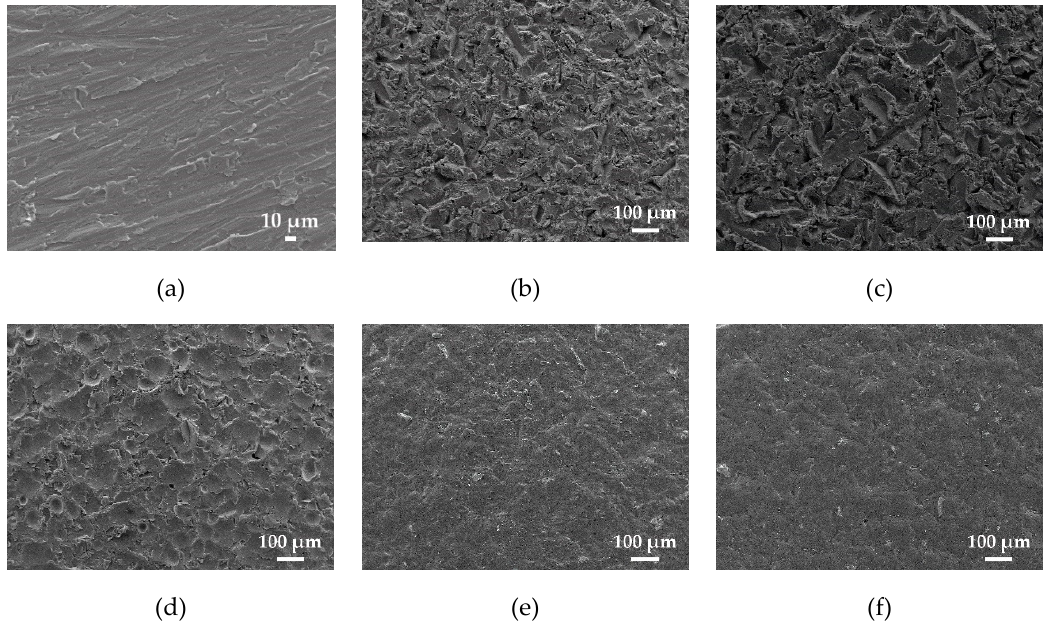
Figure 7. SEM images of the various sandblasted samples. ( a ) State of delivery, ( b ) brown corundum, ( c ) white corundum, ( d ) glass microspheres, ( e ) plastic particles, and ( f ) walnut shell.